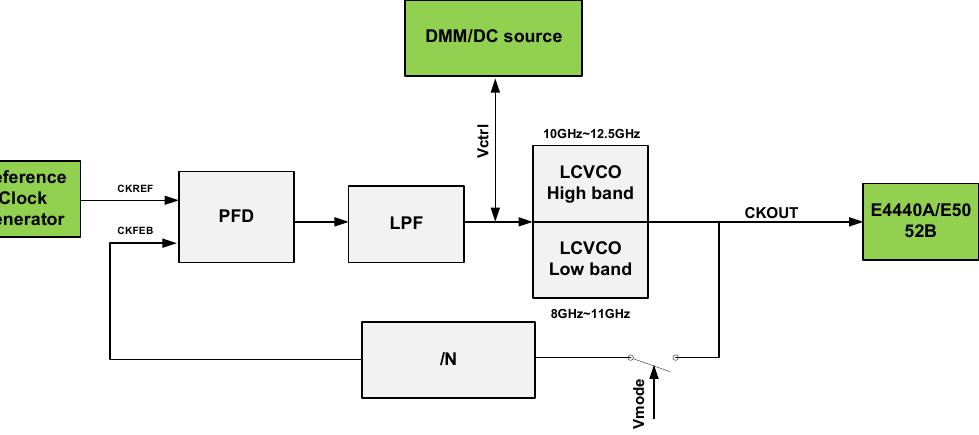
Figure 9. Block diagram of the LC PLL and LC VCO test system.